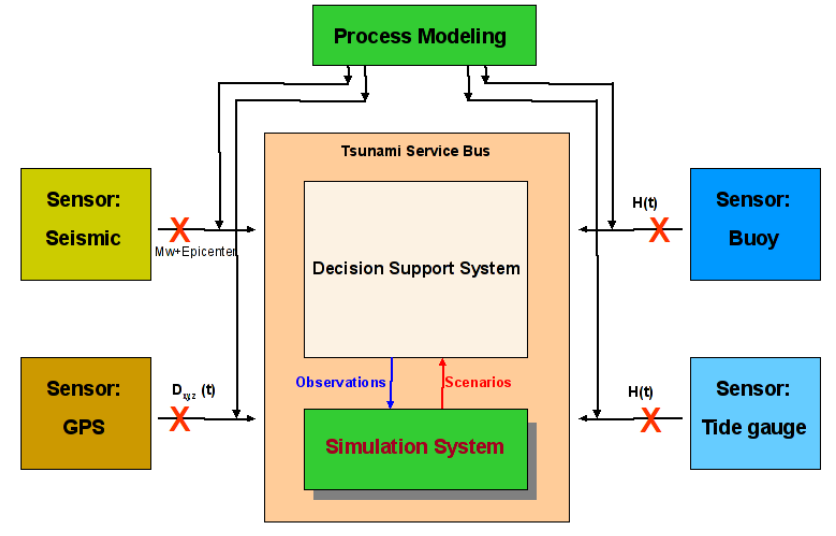
Fig. 4. Implication of the process modeling for the testing of the GITEWS core software components: Tsunami Service Bus (see also Fleischer et al., 2010), Decision Support System (Steinmetz et al., 2010) and Simulation Module. The system is being detached from real physical sensors and being feeded by pre-computed scenario datasets of different sensor